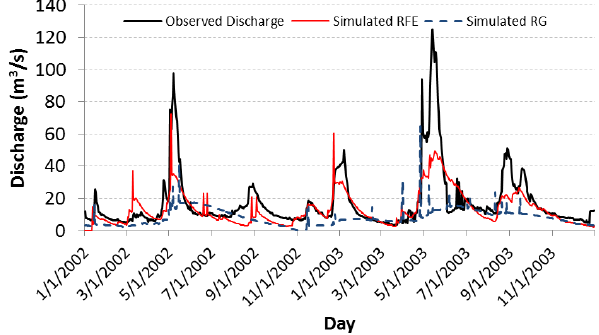
Fig. 5. Simulated daily discharge (RG and RFE Models) for dif- Figure 5. Simulated daily discharge (RG and RFE Models) for different rainfall sources for ferent rainfall sources for Nyangores River plotted with observed Nyangores River plotted with observed discharge.